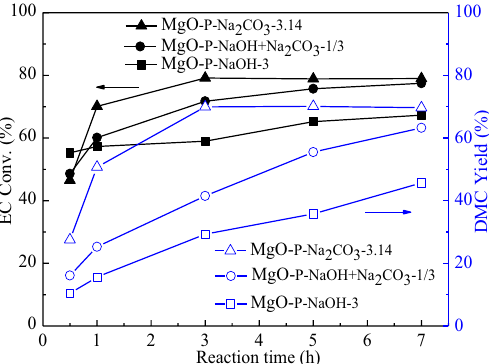
Figure 2. The effect of reaction time on the transesterification reaction. Reaction conditions: EC/MeOH = 1/6, catalyst amount = 3 wt%, reaction temperature = 68